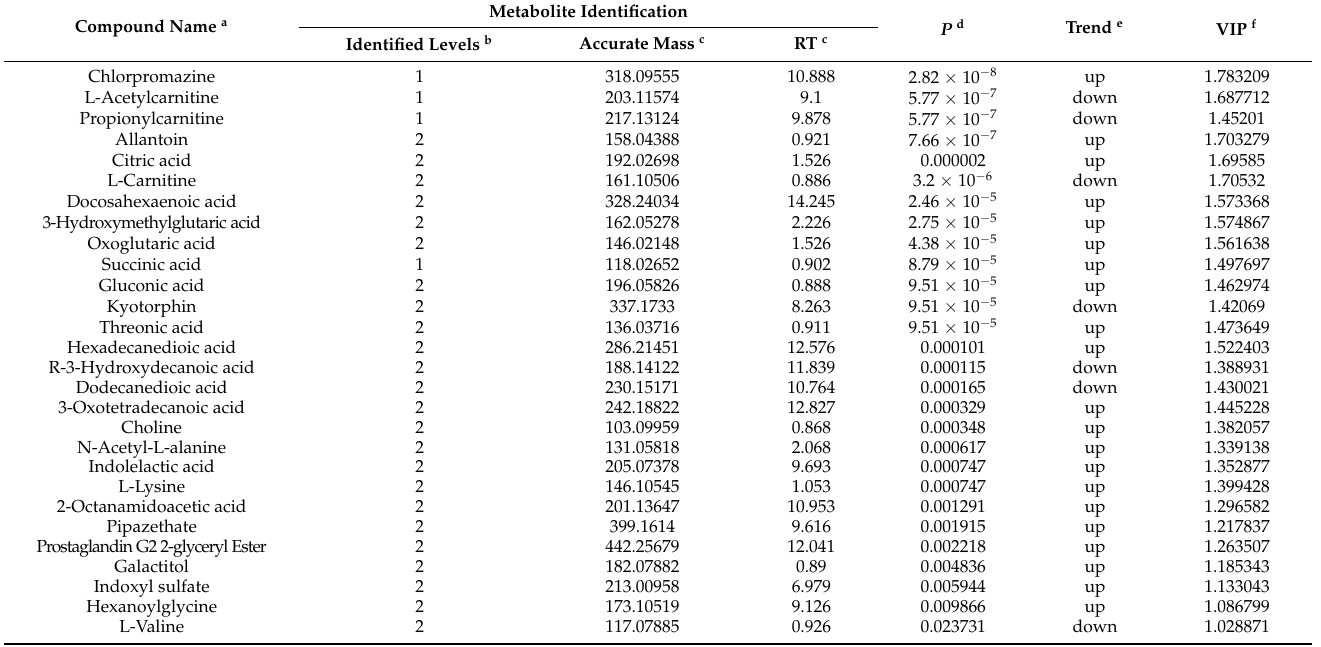
Table 2. Differential metabolites after fatal intoxication by CPZ.